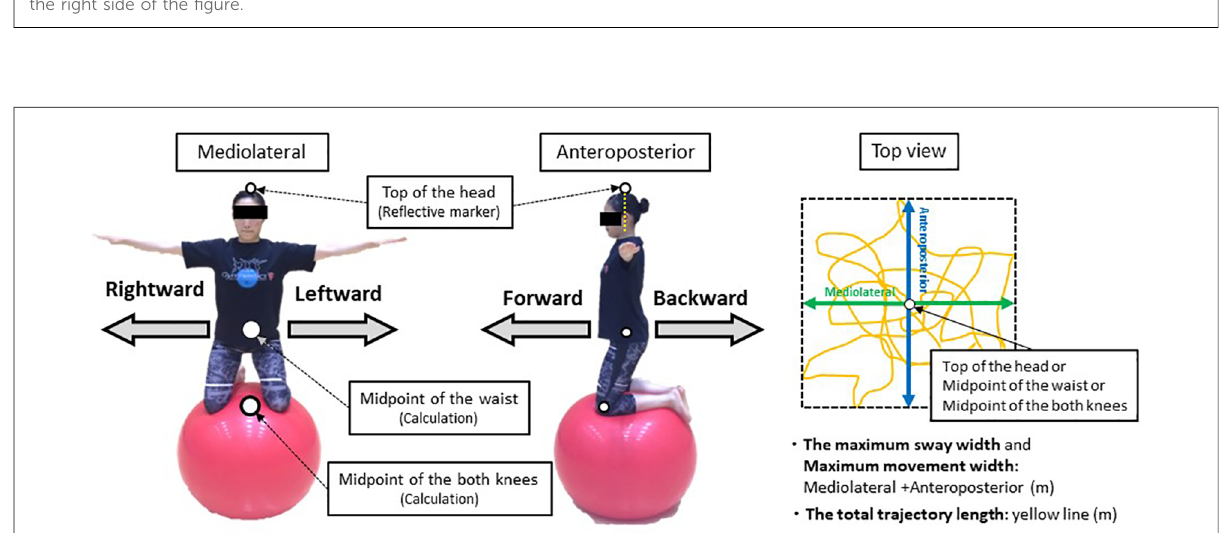
FIGURE 2 Locations of infrared re fl ection markers. Infrared re fl ective markers for motion capture were attached at 11 points to each participant. The three markers were attached to the exercise ball. The numbers in parentheses beside the markers correspond to the numbers indicating body parts on the right side of the fi